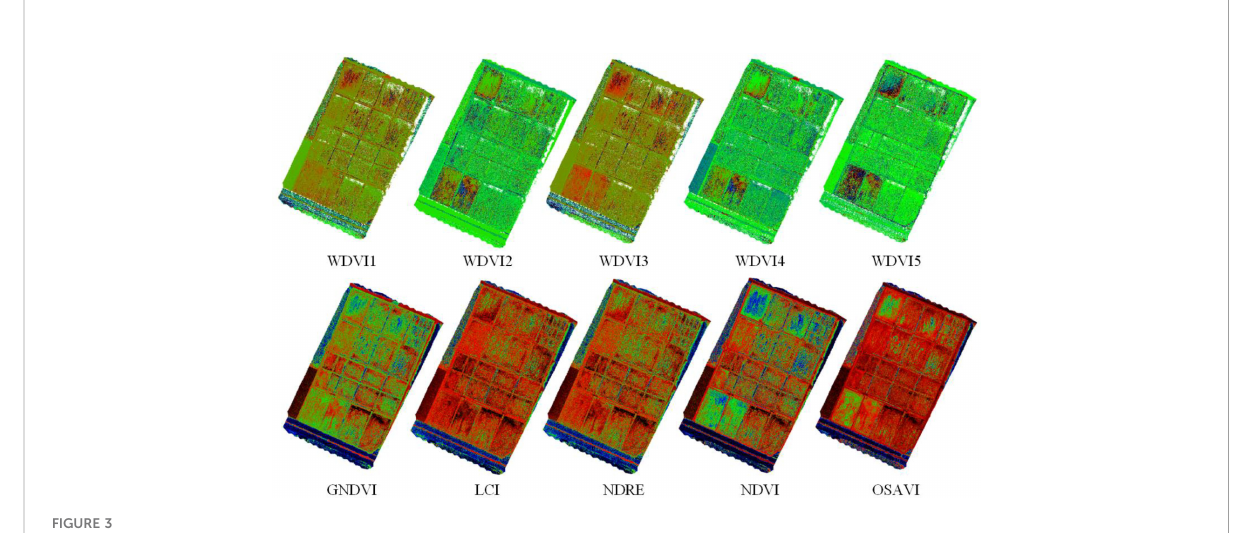
FIGURE 3 Results of weed identi fi cation with different vegetation